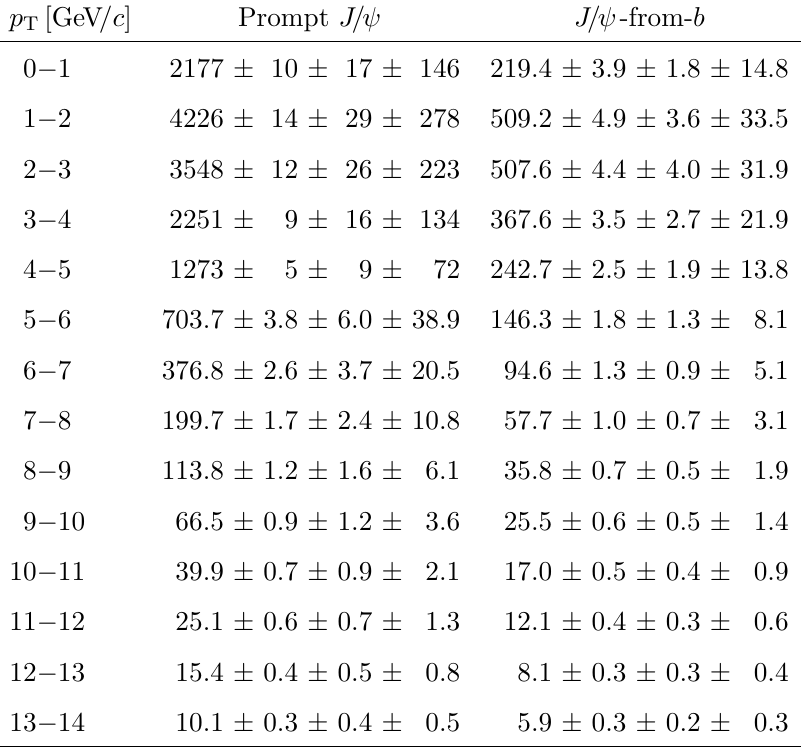
Table 7 . Di(cid:11)erential cross-sections d(cid:27)=dp T (in nb = (GeV =c )) for prompt J= and J= -from- b mesons, integrated over y . The (cid:12)rst uncertainties are statistical and the second (third) are un- correlated (correlated) systematic uncertainties amongst bins.